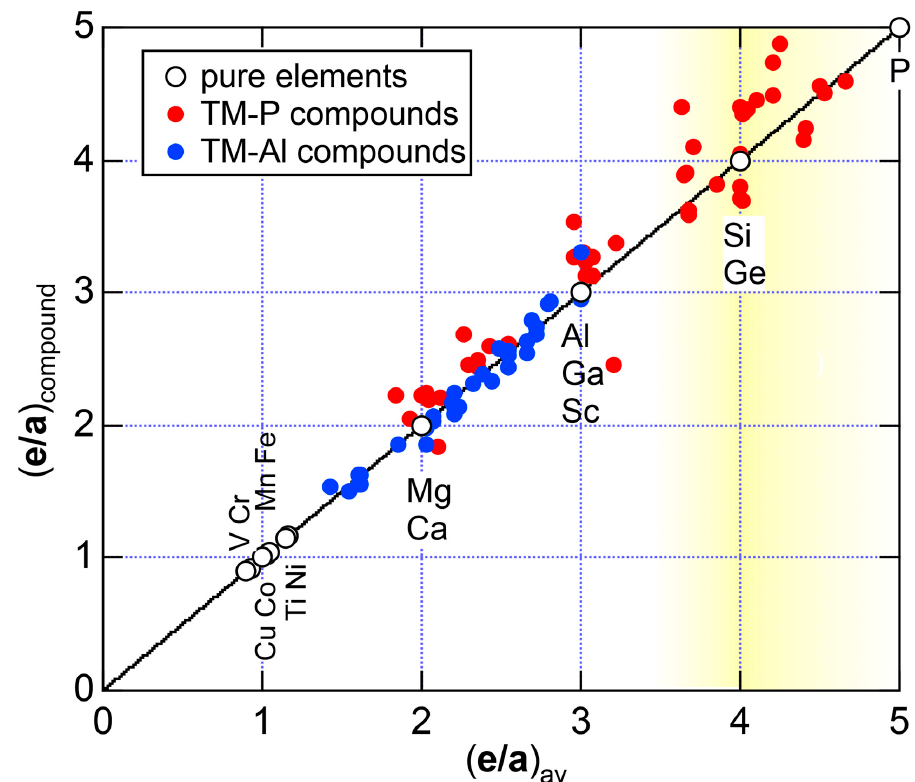
Figure 107. ( e/a ) compound versus ( e/a ) av for Al-TM ( • ) and P-TM ( • ) compounds studied in the present work, where TM covers from Sc to Cu in Period 4 in the Periodic Table. The data from Figures 54 and 74 are combined. The data for pure elements marked with open circles are located on the line ( e/a ) compound = ( e/a ) av . Numerical data in Table 1 are rounded off to the nearest integer or valence for simple elements but are used as they are for TM elements. The yellow gradation area is centered at e/a = 4.0.